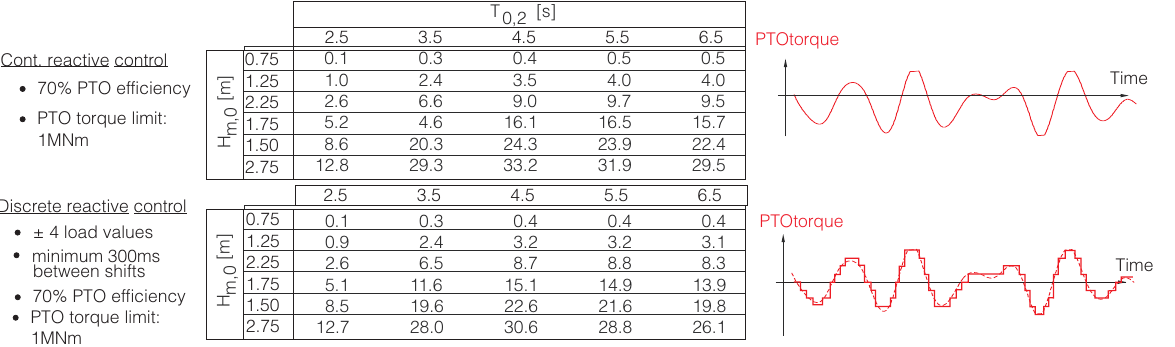
Figure 23. Power matrices of average produced power in [kW]. The matrices are shown for a continuous torque control and a discrete control with